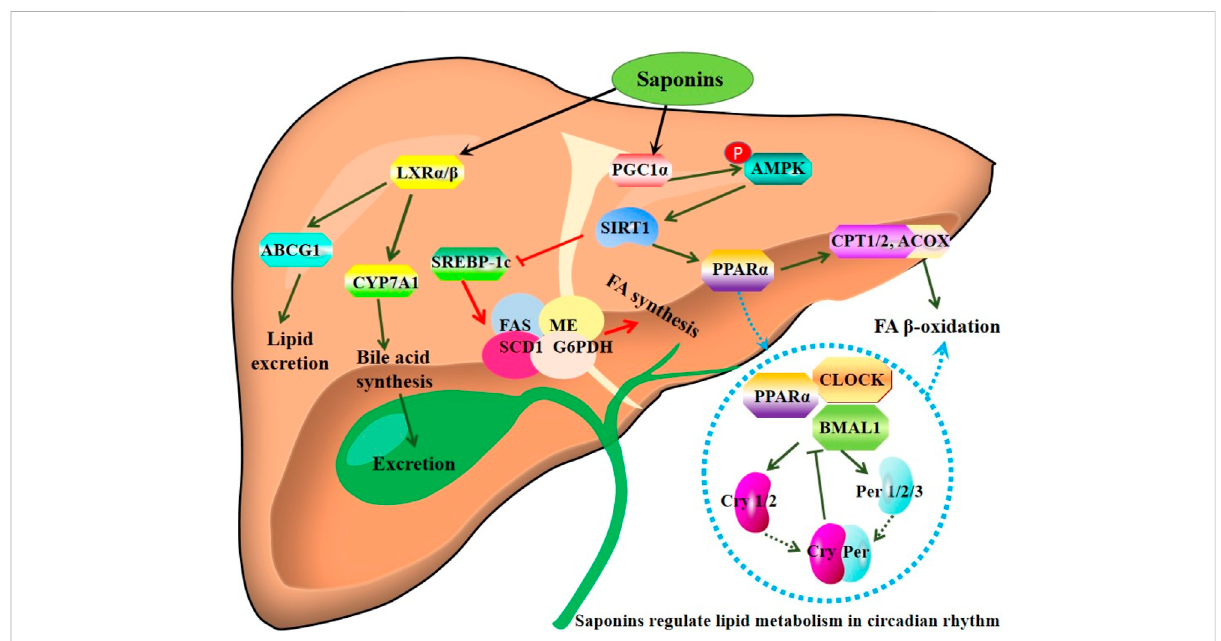
FIGURE 2 Mechanisms of action of saponins derived from sea cucumbers. Saponins stimulate LXR and AMPK/PPAR α signaling pathways, thereby promoting lipid expression and fatty acid (FA) β -oxidation. Of note, these saponins regulate lipid metabolism-related genes in circadian rhythm. ABCG1: ATP-binding cassette transporter G1; ACOX1: acyl-CoA oxidase 1; AMPK: AMP-activated protein kinase; Cry: cryptochrome gene; CYP7A1: cholesterol 7- α -hydroxylase A1; FAS: fatty acid synthase; G6PDH: glucose-6-phosphate dehydrogenase; LXR: liver X receptor; ME: malic enzyme; CPT1: carnitine palmitoyl transferase 1; PGC-1 α : peroxisome proliferator-activated receptor- γ co-activator 1 α ; Per: period gene; PPAR α : peroxisome proliferator activated receptor α ; SCD-1: Stearoyl-CoA desaturase-1; SIRT1: Sirtuin 1; SREBP-1c: sterol regulatory element-binding protein-1c. All the abbreviations are applicable for the rest